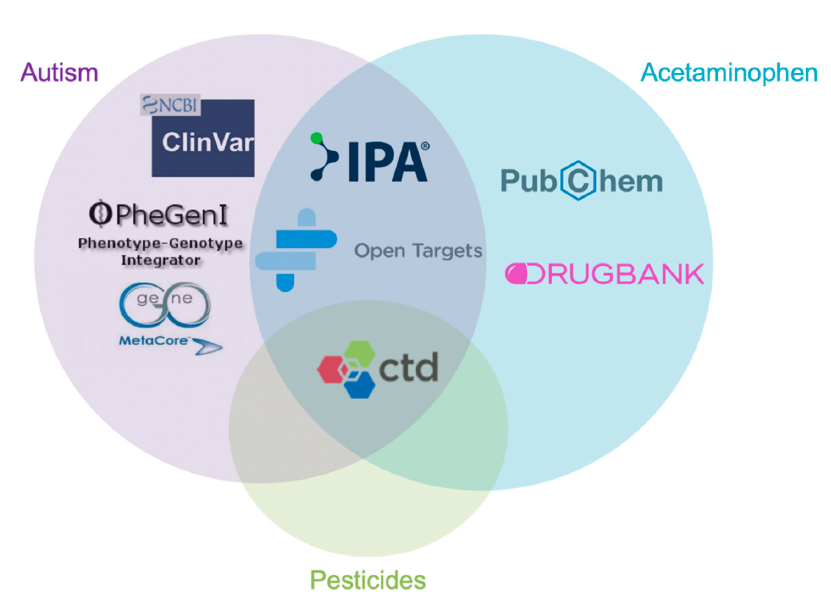
Figure A1. Data acquisition of lists of candidate genes were taken from various molecular data- bases. Databases include Comparative Toxicogenomics Database, Pubchem, Open Targets Plat- form, Ingenuity Pathway Analysis, DrugBank, PhegenI, MetaCore, and Clinvar. Each of these da- tabases was used for one or more of the three factors, these being acetaminophen, pesticides and or autism.